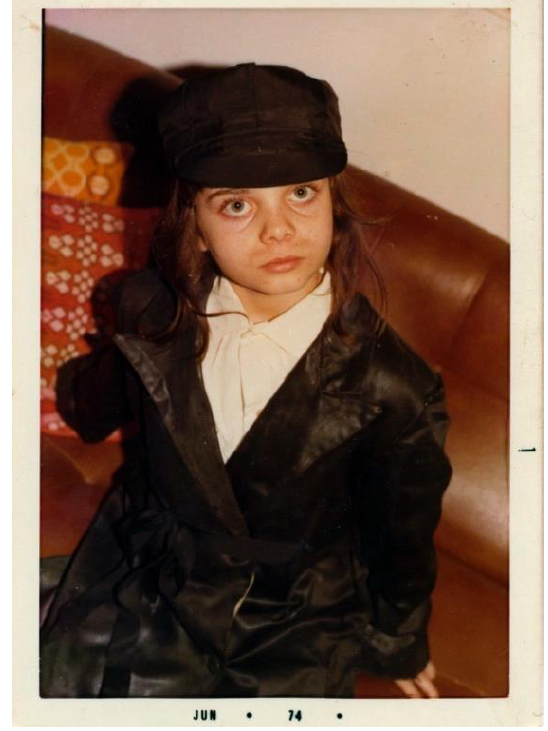
Figure 2. Oreet Ashery, Boy Marcus , 1974/ongoing. Photo by unknown family photographer. Cour- tesy of the artist.